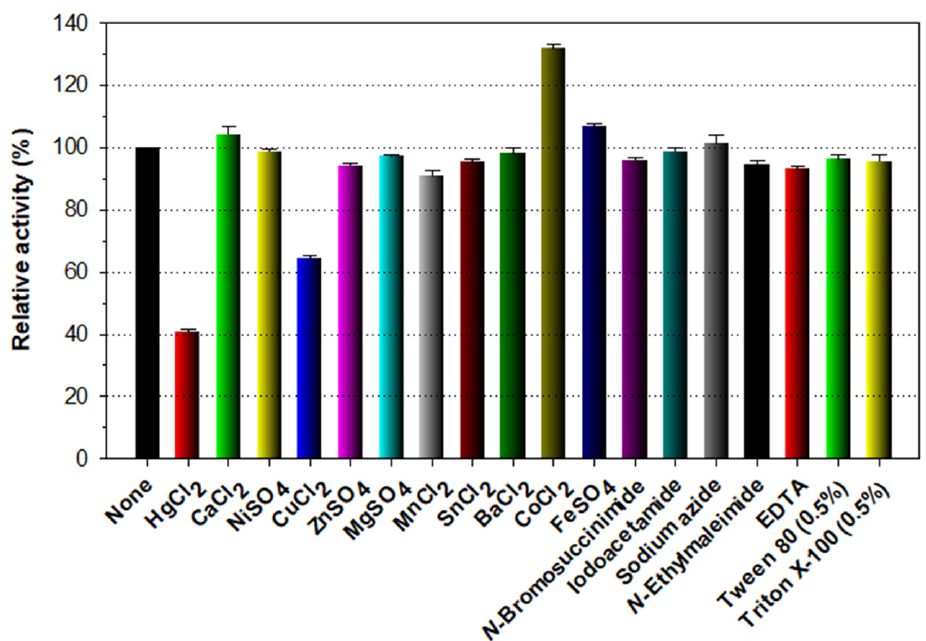
Figure 5. Effects of metal ions (1 mM) and chemical reagents (5 mM) on the endochitinase activity of rChiJ. The values are mean ± SD of triplicate tests.